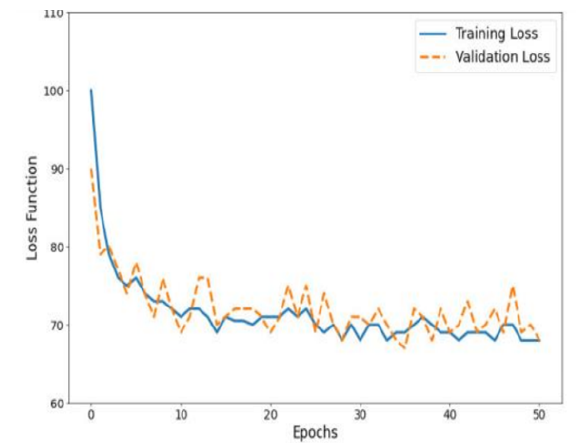
Fig. 10. Graph of loss function when training on